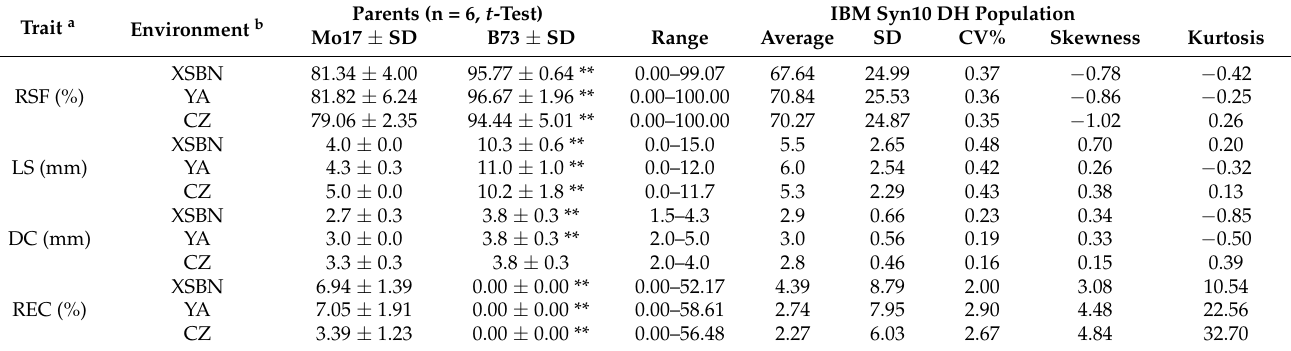
SD, standard deviation, CV, coefficient of variation. ** The difference is significant at the p = 0.01 level between B73 and Mo17. a RSF, LS, DC, and REC represent the rate of shoot formation, length of shoot, diameter of Int. J. Mol. Sci. 2022 , 23 , x FOR PEER REVIEW callus, and rate of embryogenic callus induction. b XSBN, YA, and CZ represent the three environments, namely Xishuangbanna, Ya’an, and Chongzhou, respectively.